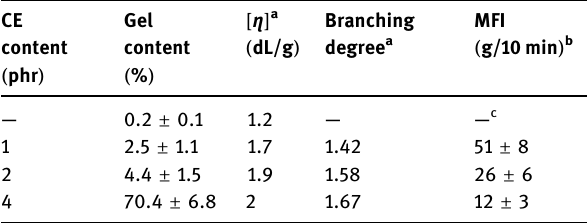
a Measured from soluble fraction of PLLA - PEG - PLLA in chloroform.